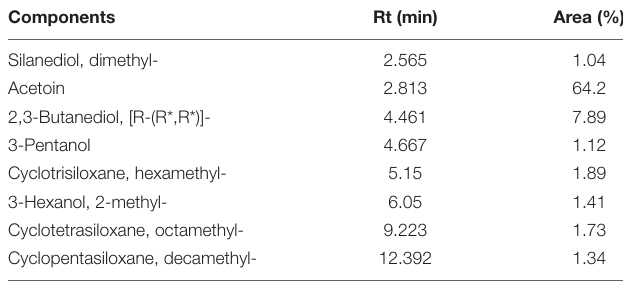
TABLE 2 | Effects of Bacillus licheniformis strain JF-22 on tomato plant growth and root-nematode disease severity. Treatment JF-22